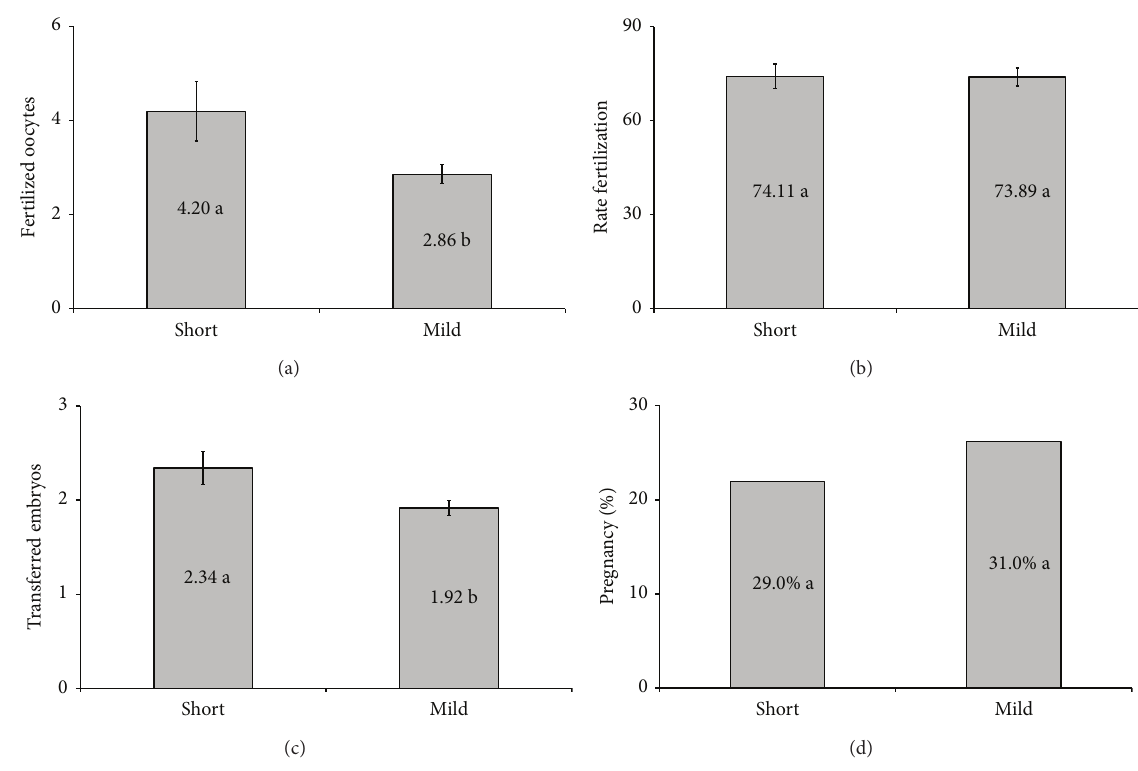
Figure 5: Fertilization rates and pregnancy: (a) average oocytes fertilized, (b) fertilization rate, (c) average number of embryos transferred, and (d) the pregnancy rate. Means followed by the same letter do not differ significantly by 𝑡 -test at 5%